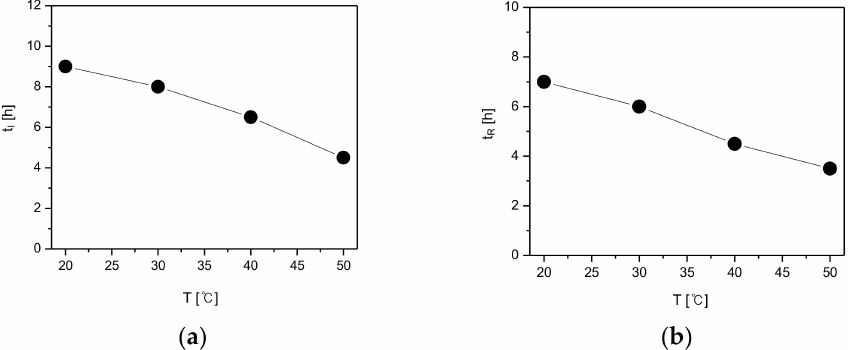
Figure 11. Effect of temperature on polymorphic transformation: ( a ) induction time, and ( b ) reconstruction